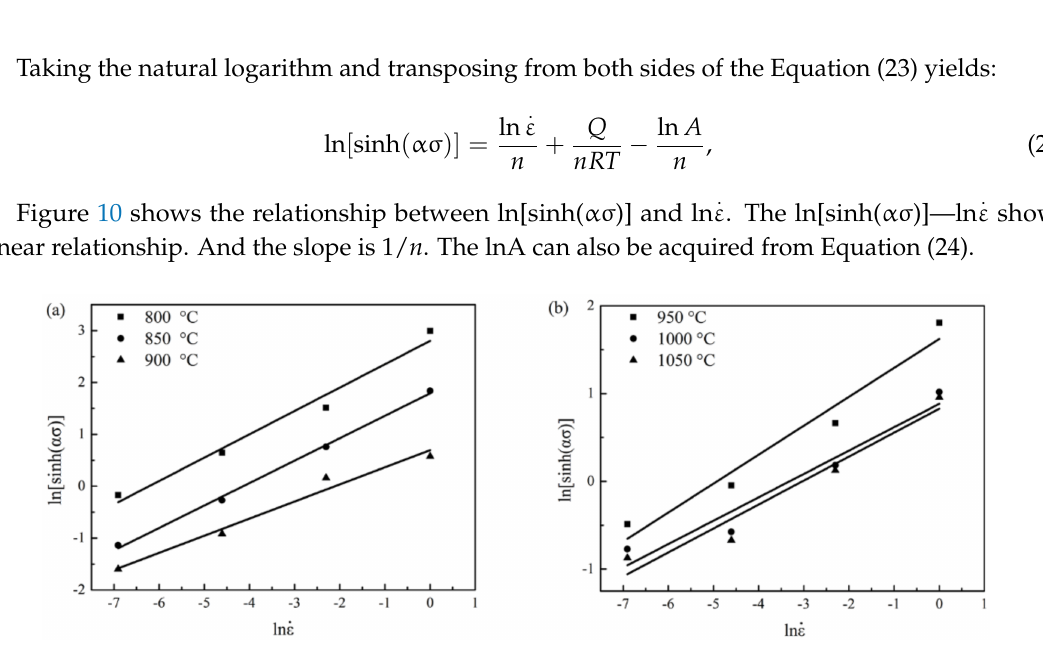
Figure 10. The relationship between ln[sinh( ασ )]—ln